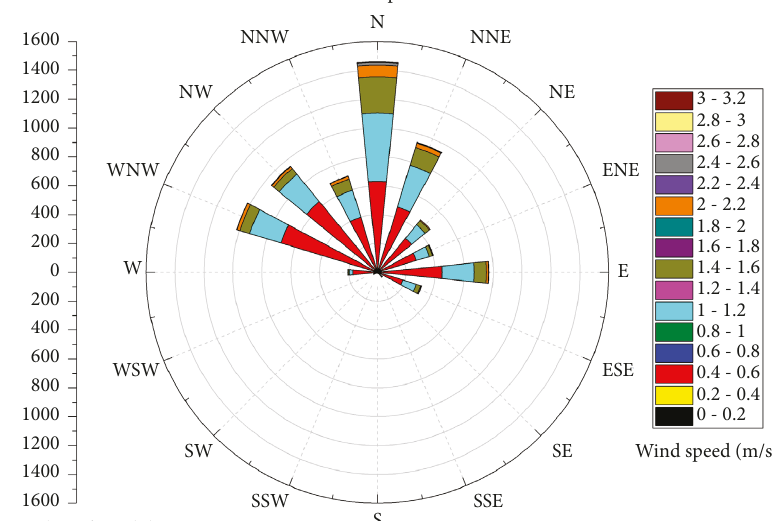
Figure 4: Analysis of wind direction and speed.